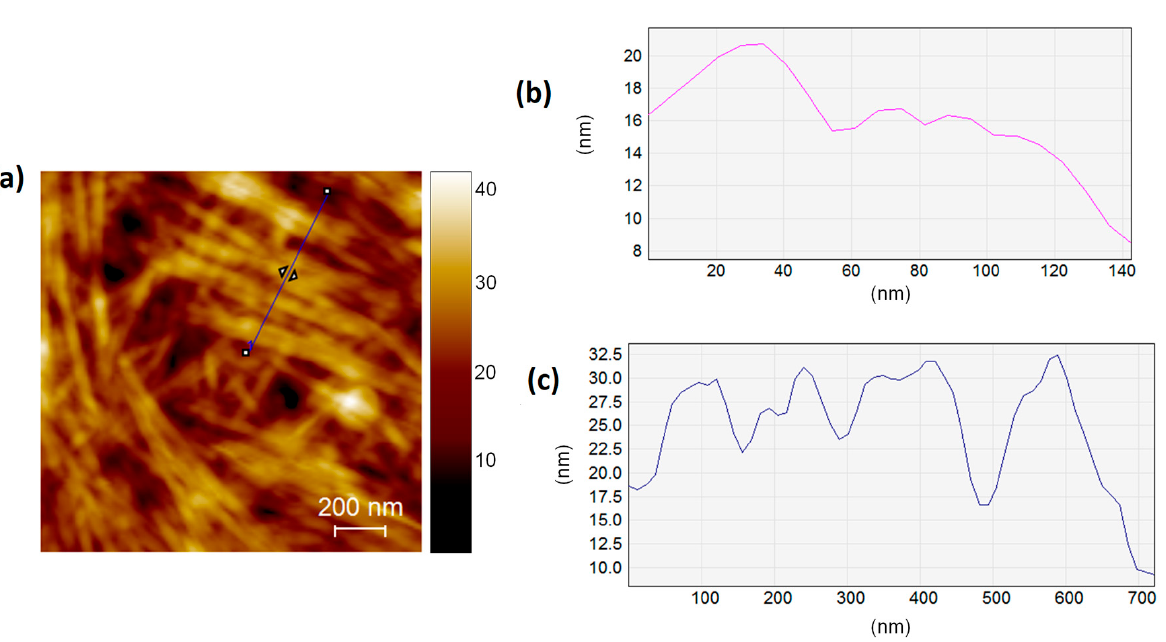
Figure 8. AFM height image (1.5 × 1.5 µ m 2 ) of AK1841045 ( a ) and height line profile measured on the topographies indicated by blue and pink lines ( b , c ). AFM images show the presence of tubular structures which self-organized in ribbons. Graphs display the height and width of tubular structures ( b ) and ribbons ( c ). AFM measurements were performed in tapping mode on dry samples.